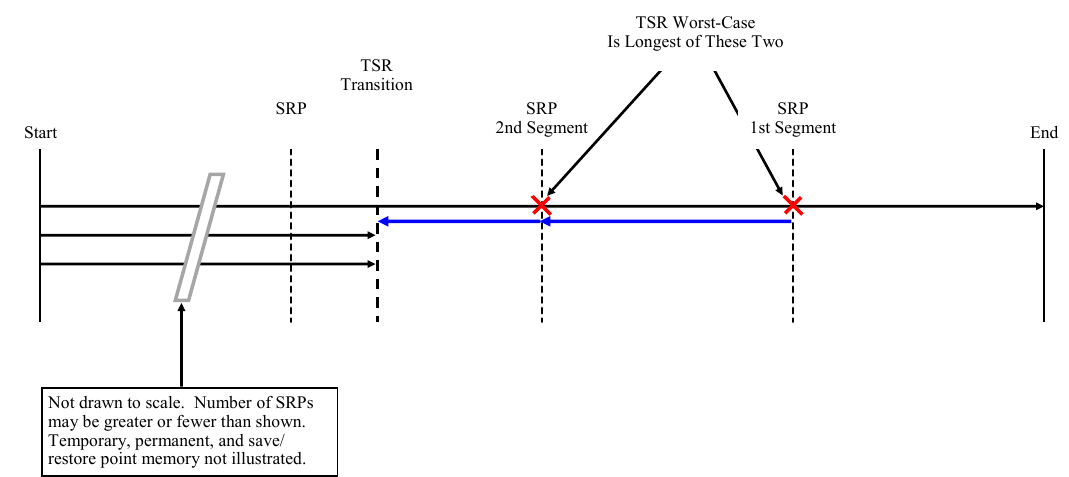
Figure A18. AHR MIPS TSR Worst-Case Early Error Timing Diagram 2.